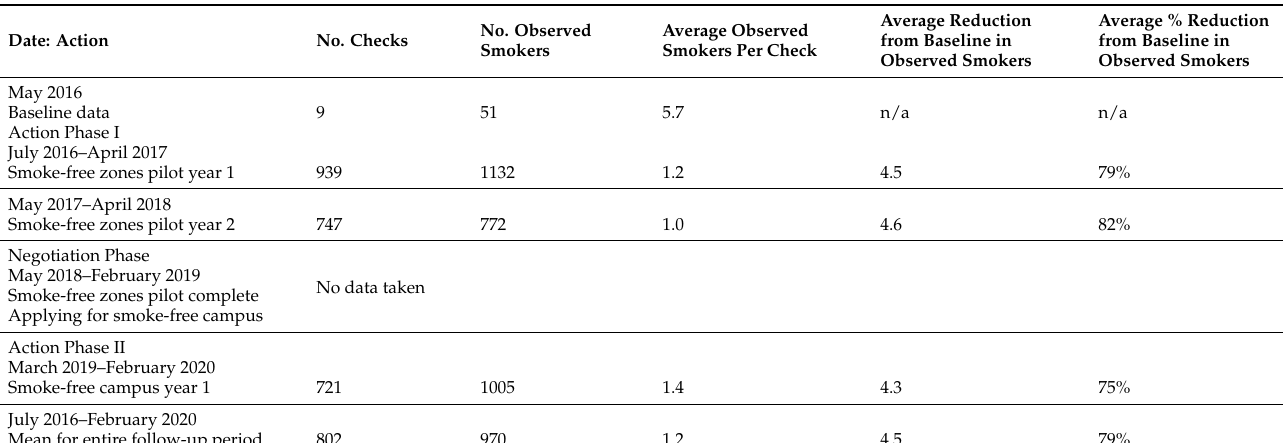
Table 2. Observed smokers at baseline, during two years of a smoke-free zones pilot and during one year of a smoke-free campus